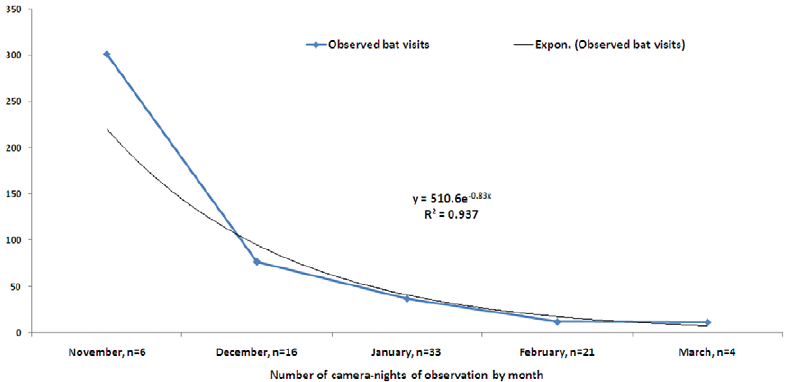
Figure 4. Average number of bat visits per camera-night around the date palm tree (without intervention) during the date palm sap harvesting season in2009 and 2010.